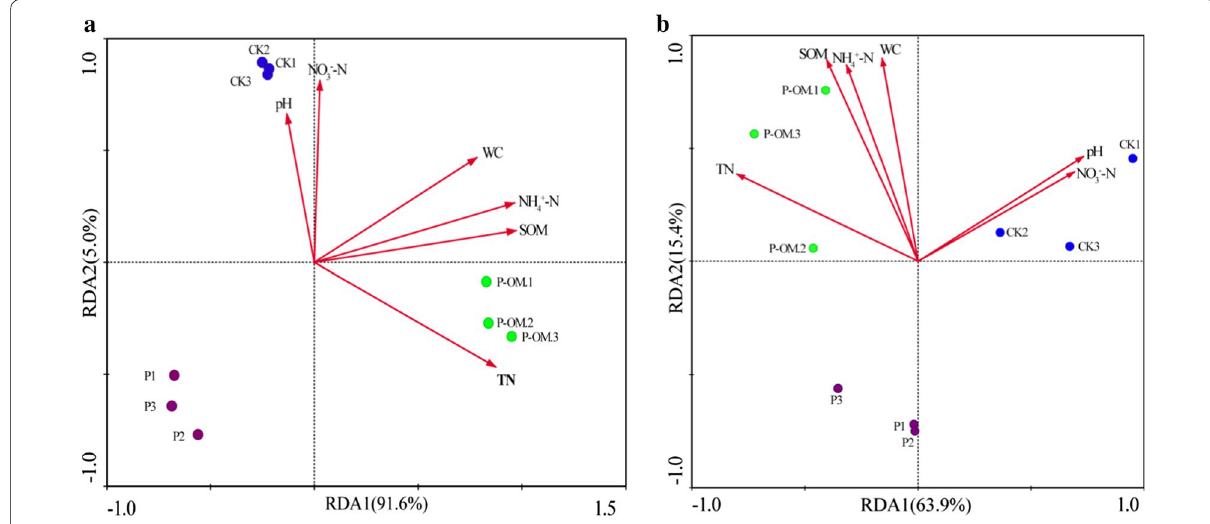
Fig. 5 Redundancy analysis based on the bacterial ( a ) and fungal ( b ) community structure and soil chemical variables